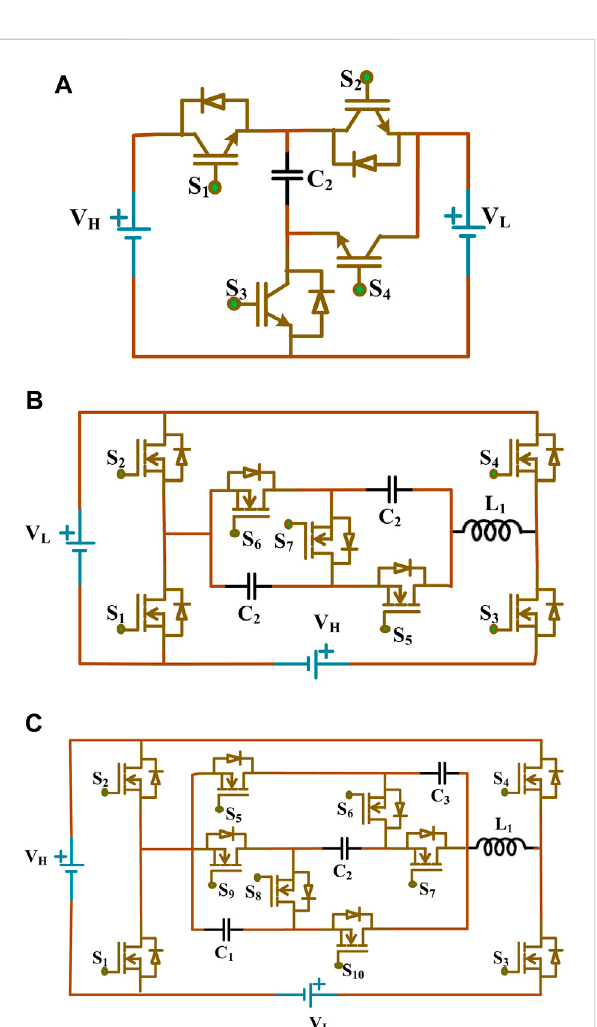
FIGURE 7 Switched capacitor converters (A) bidirectional (B) single-level quasi-resonant (C) two-level